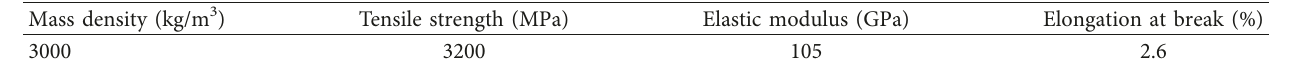
Figure 2: Corrosion of specimens: (a) beginning; (b) during corrosion; (c) after corrosion; (d) corroded crack. Table 3: Mechanical properties of BFRP sheets.